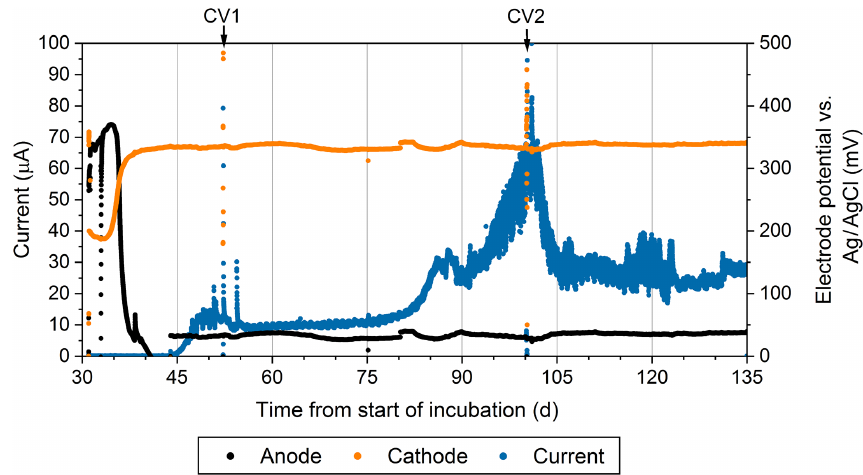
Figure 4. The current production (blue), the anodic potential (black), and cathodic potential (orange) over time during the reactor experiment. The reference electrode was an Ag / AgCl electrode with a saturated KCl filling solution. This figure only shows measurements associated with one of the duplicate